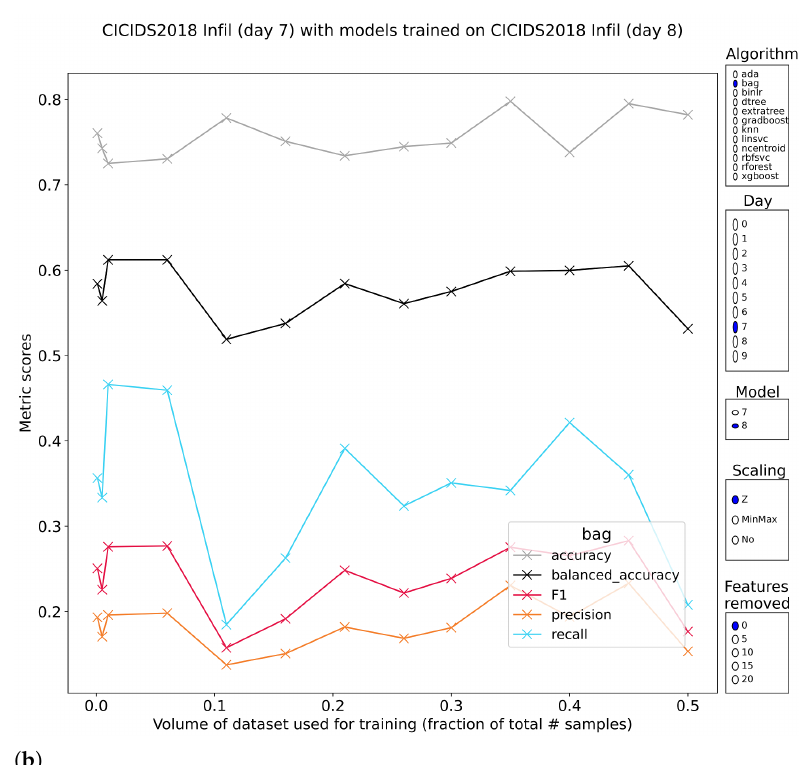
Figure 4. A visual representation of the broken link between training volume and model performance, observed in the breakdown of models trained on subset 2 of infiltration traffic ( a ) when classifying their subset’s test set and the same set of models’ performance on subset 1 of infiltration traffic ( b